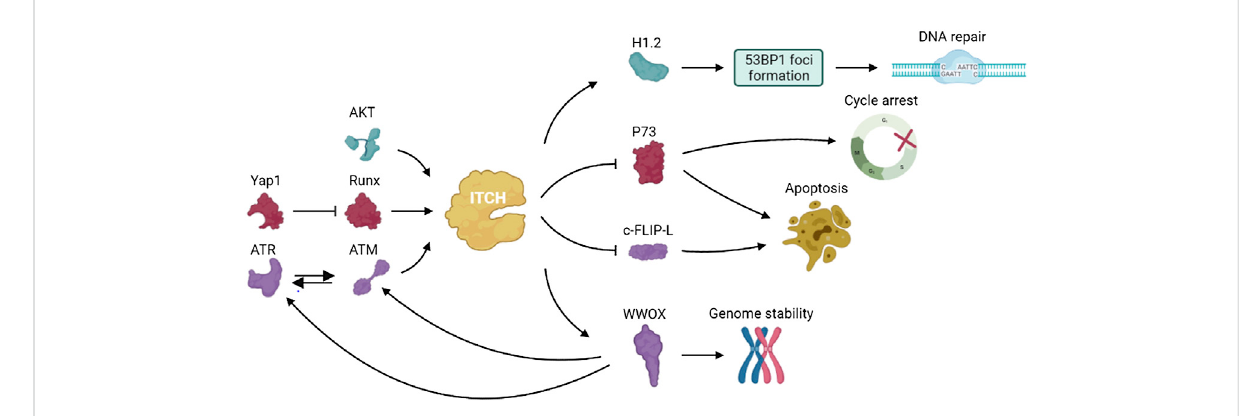
FIGURE 4 The pathways involved in DDR of ITCH.